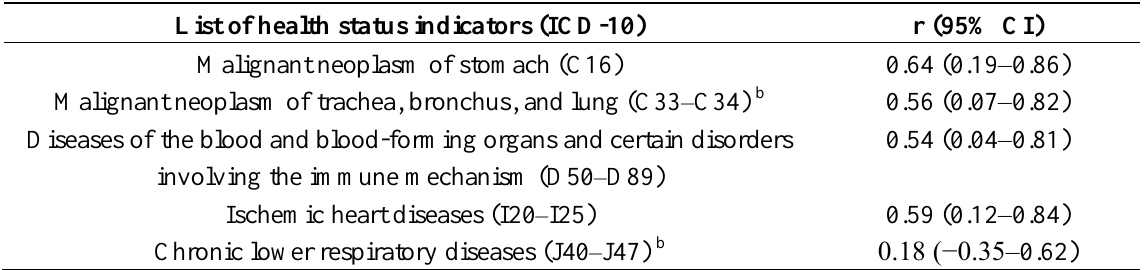
Table 5. The correlation coefficient between S Health Status